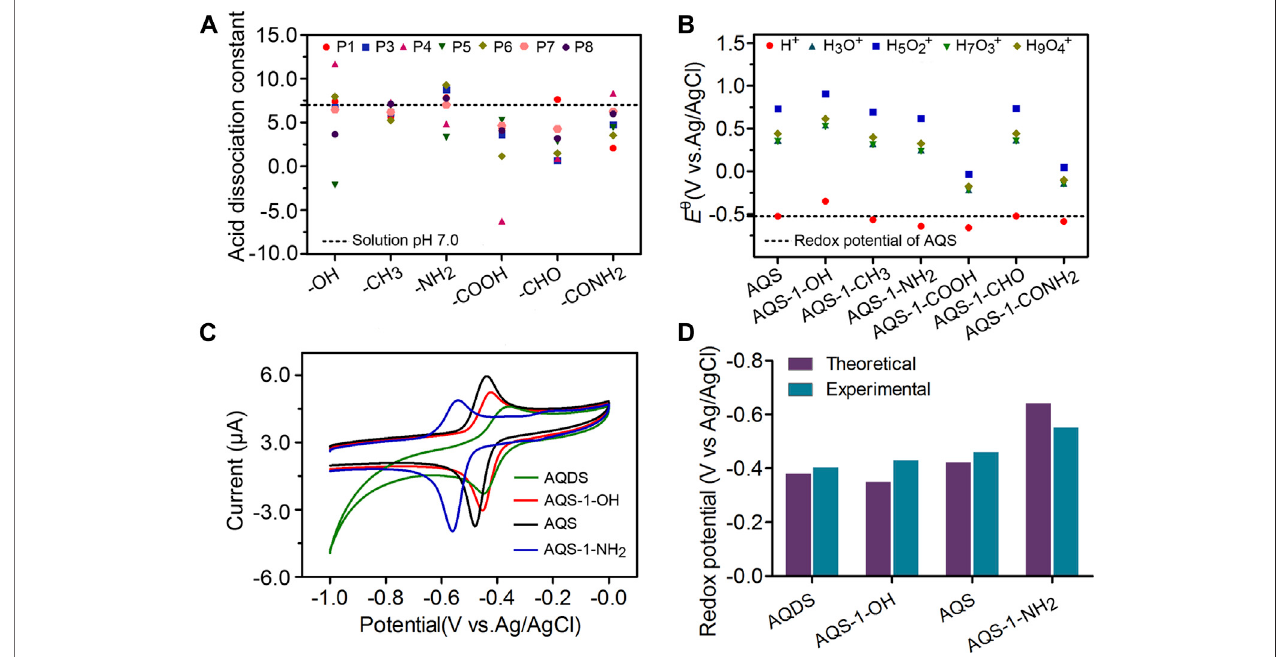
AQS-1derivatives. (C) TheCVassaysofAQSandthreeotherderivatives. (D) Thetheoreticalredoxpotentialsweredeterminedbythequantumchemicalcalculation,and the experimental redox potentials were calculated based on the CV assay. Results are representative of at least two independent experiments performed in triplicate and are expressed as mean ± standard deviation